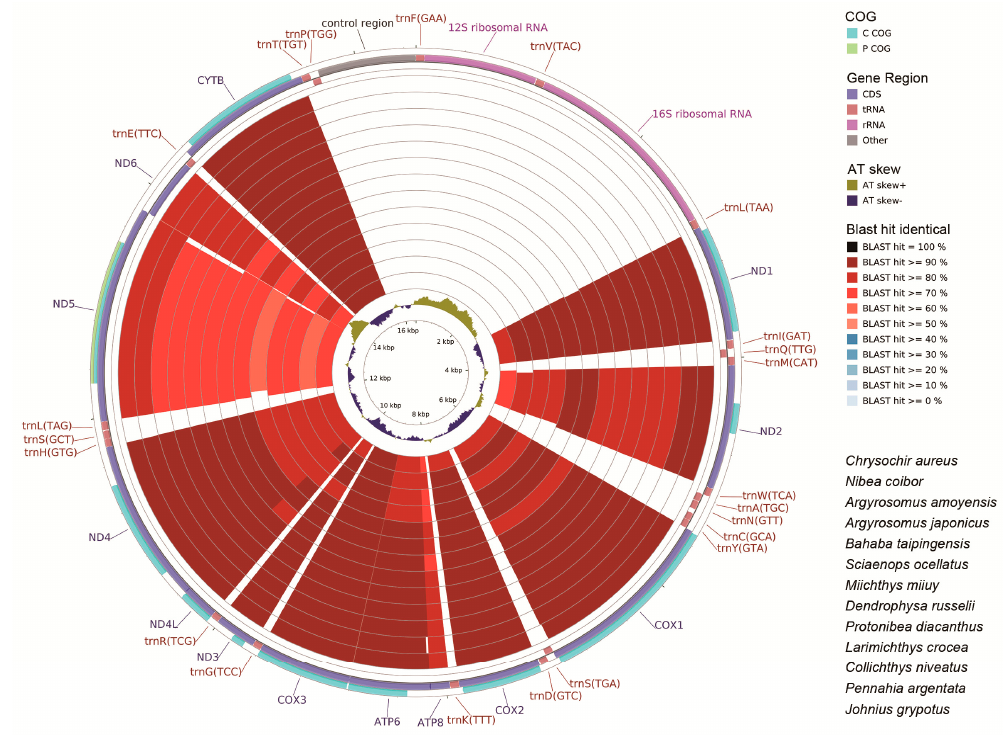
Figure 7. Graphical map of the BLAST results showing the mitochondrial cds (coding DNA sequence) identity between Nibea albiflora (NC_015205) (Perciformes, Sciaenidae) and other Sciaenidae species, using the CGView comparison tool (CCT). CCT arranges BLAST result in an order where sequence that is most similar to the reference ( N. albiflora ) is placed closer to the outer edge of the map. Note: COG (Clusters of Orthologous Groups of proteins), gene region, Blast identity, and AT skew are shown from outside to inside. The species from outside to inside as follows, respectively: Chrysochir aureus